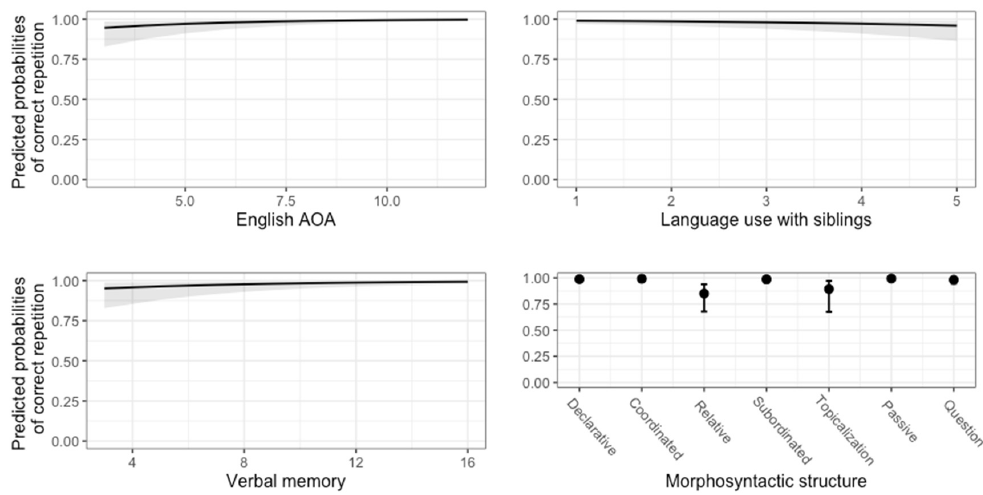
Figure 8. Predicted probabilities of a correct response given each fixed effect in the optimal model of Arabic T2, predicting correct repetition of target morphosyntactic structure.